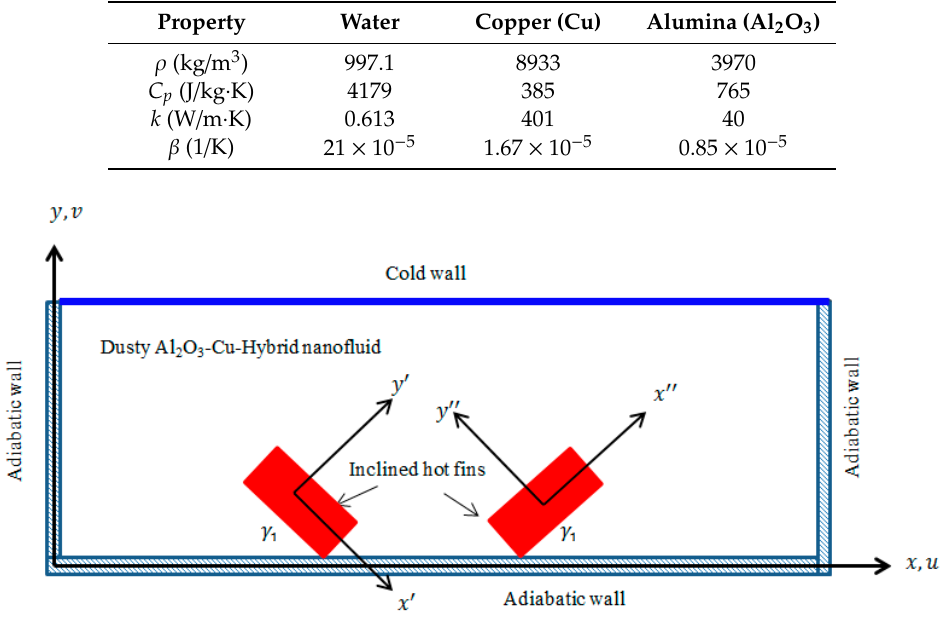
Table 1. Thermo-physical properties of the base fluid and nanoparticles.